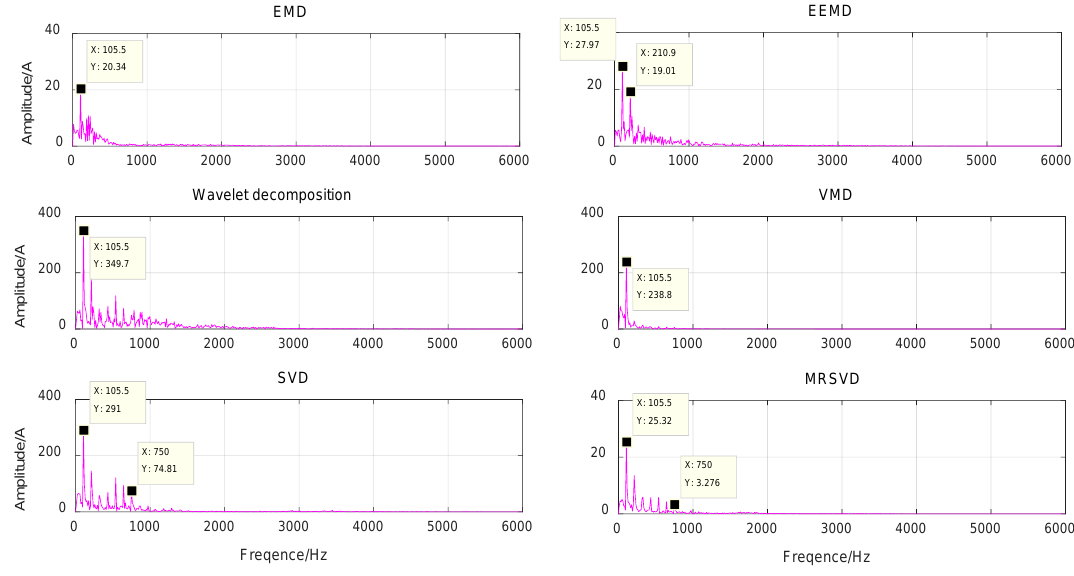
Figure 11. Envelope spectra of fault characteristics of six models.